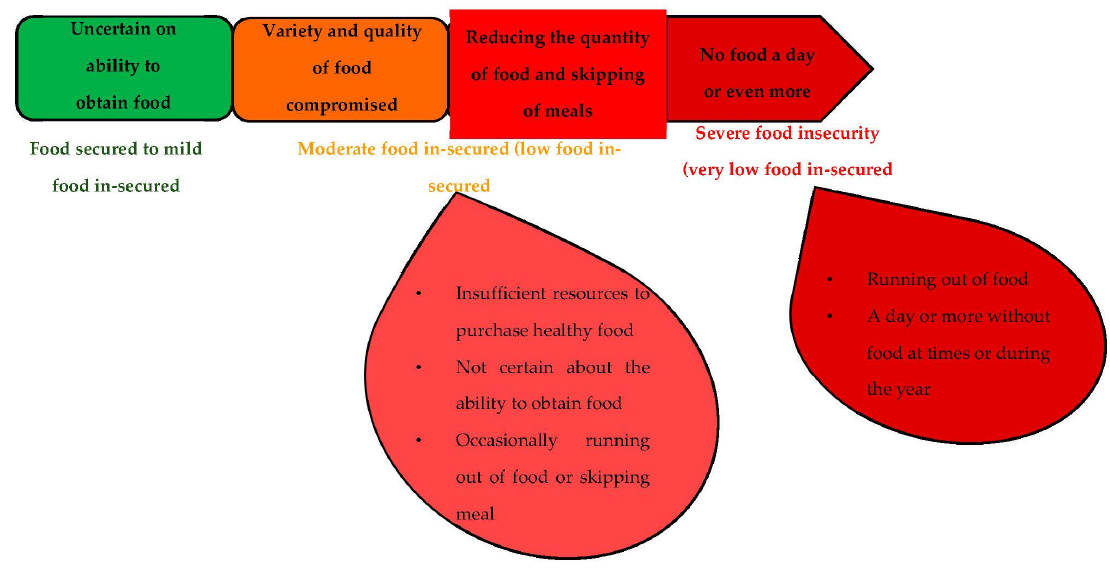
Figure 1. Food insecurity scale [2].